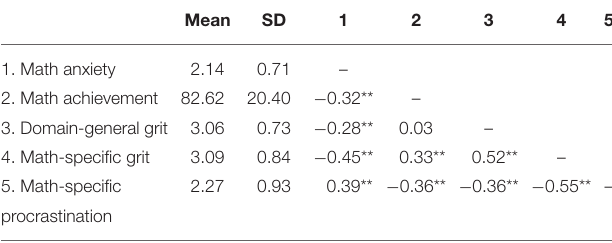
TABLE 2 | Means, standard deviations (SD), and correlations among the major variables in Study